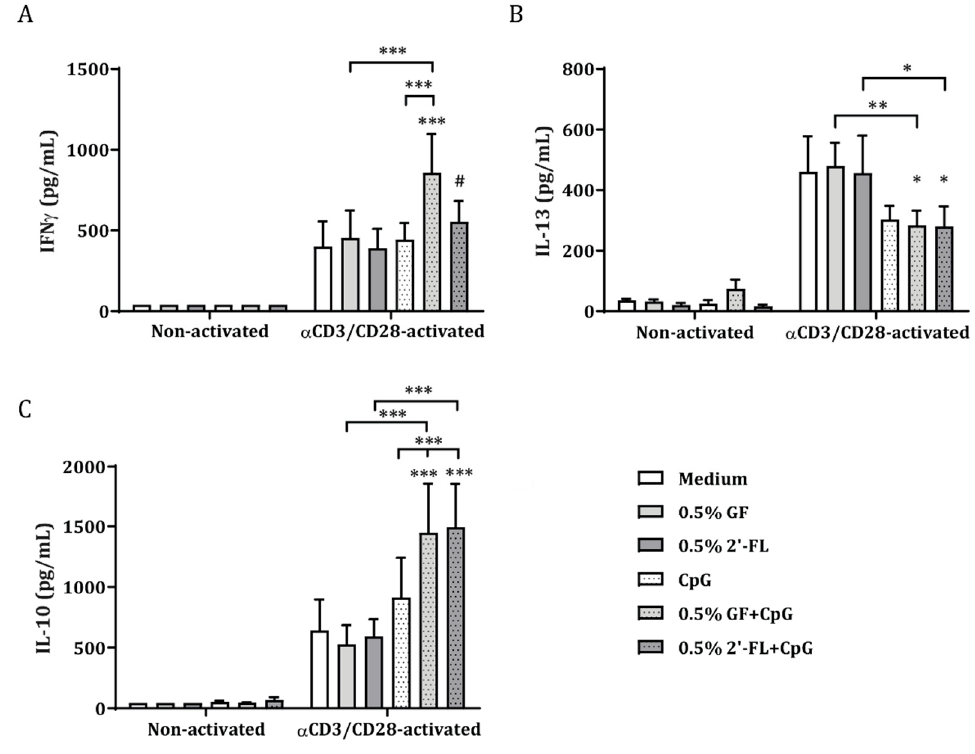
Figure 2. Cytokine secretion in IEC/PBMC co-culture after exposure to non-activated or α CD3/CD28- activated PBMC. IEC were basolaterally co-cultured with either α CD3/CD28-activated or non- activated PBMC for 24 h. Apically, IEC were exposed to 2 ′ -FL or GF alone or in combination